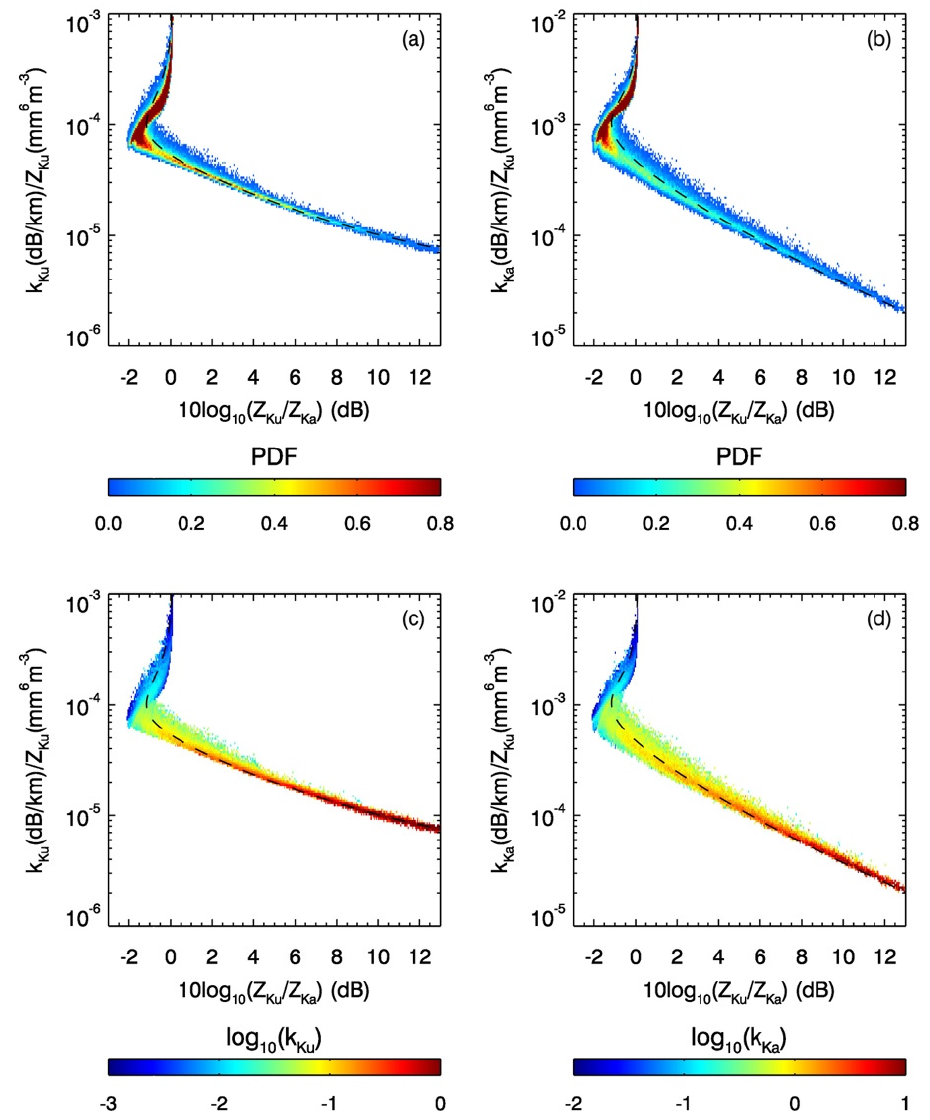
Figure 8. PDFs of the data obtained from the measured DSD. ( a ) Relationship between k Ku / Z Ku and DFR. ( b ) Same as ( a ) but for k Ka / Z Ku –DFR. Also shown are the images of the averaged k Ku and k Ka in the planes of the k Ku / Z Ku –DFR ( c ) and k Ka / Z Ku –DFR ( d ), respectively. The computational results from the gamma DSD model with µ = 3 (black dashed lines) are provided.